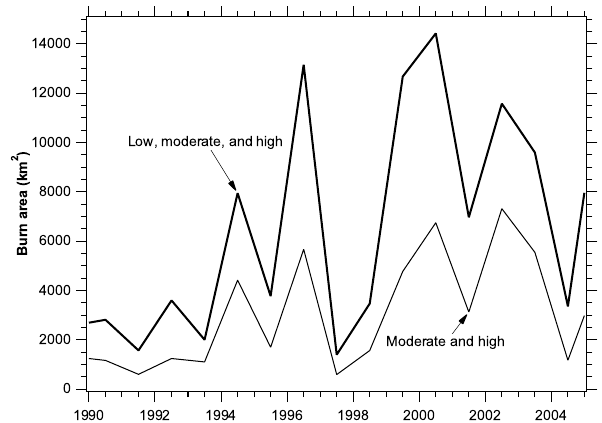
Fig. 6. Annual burn areas for the continental United States by fire severity from the Monitoring Trends in Burn Severity project of the US Forest Service and US Geological Survey (http://mtbs.gov/data/ search.html).